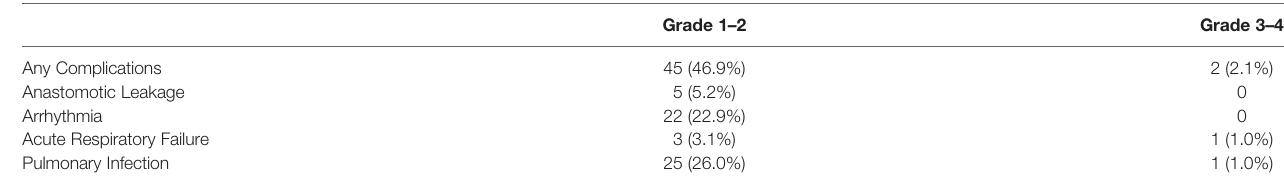
TABLE 4 | Surgical